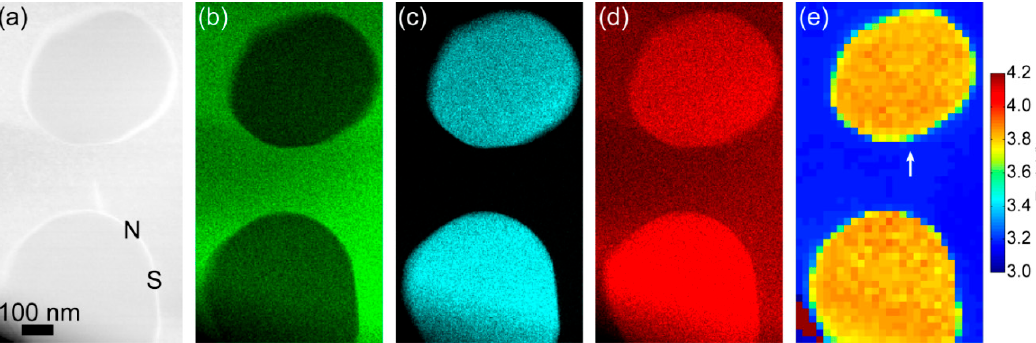
Figure 2. ( a ) Annular dark field (ADF) image of ZnO matrix and ZnCr 2 O 4 nanoparticles; EDX maps of ( b ) Zn, ( c ) Cr, ( d ) O; ( e ) Band gap map.